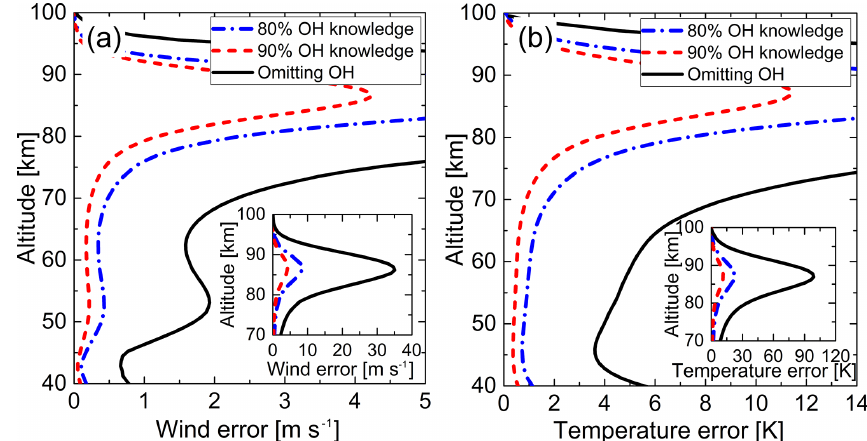
Figure 6. Inversion errors in wind and temperature due to omitting the presence of OH dayglow (black curve) and with 80% and 90% knowledge of the OH dayglow (blue short-dash–dot line and the red short-dash line). (a) The wind error profiles. (b) The temperature error profiles. The inset panels of (a) and (b) show the wind and temperature error in the altitude range